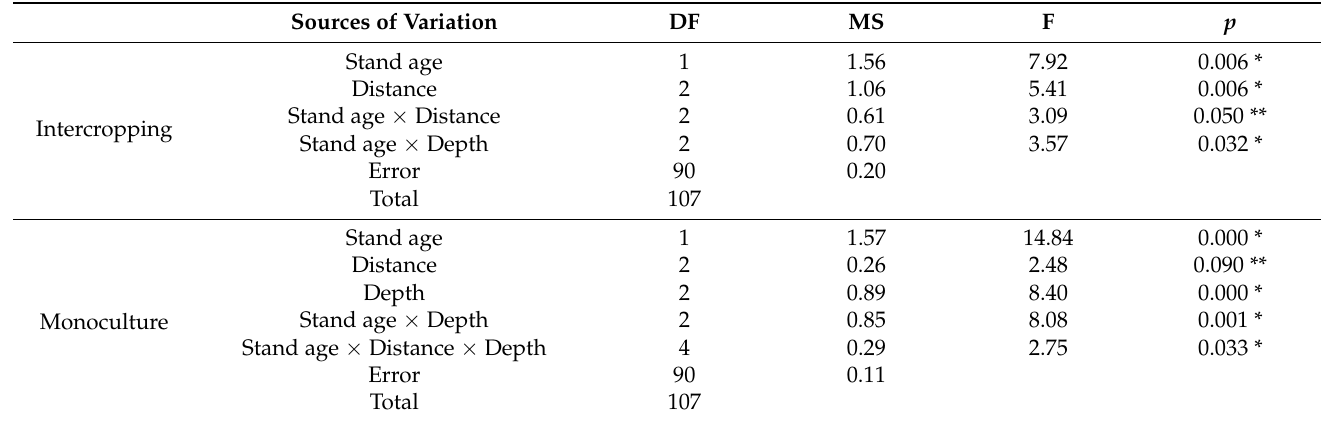
Table 3. ANOVA results for the effects of stand age, distance from the tree, and soil depth on root dry mass of E. camdulensis in monoculture and intercropped